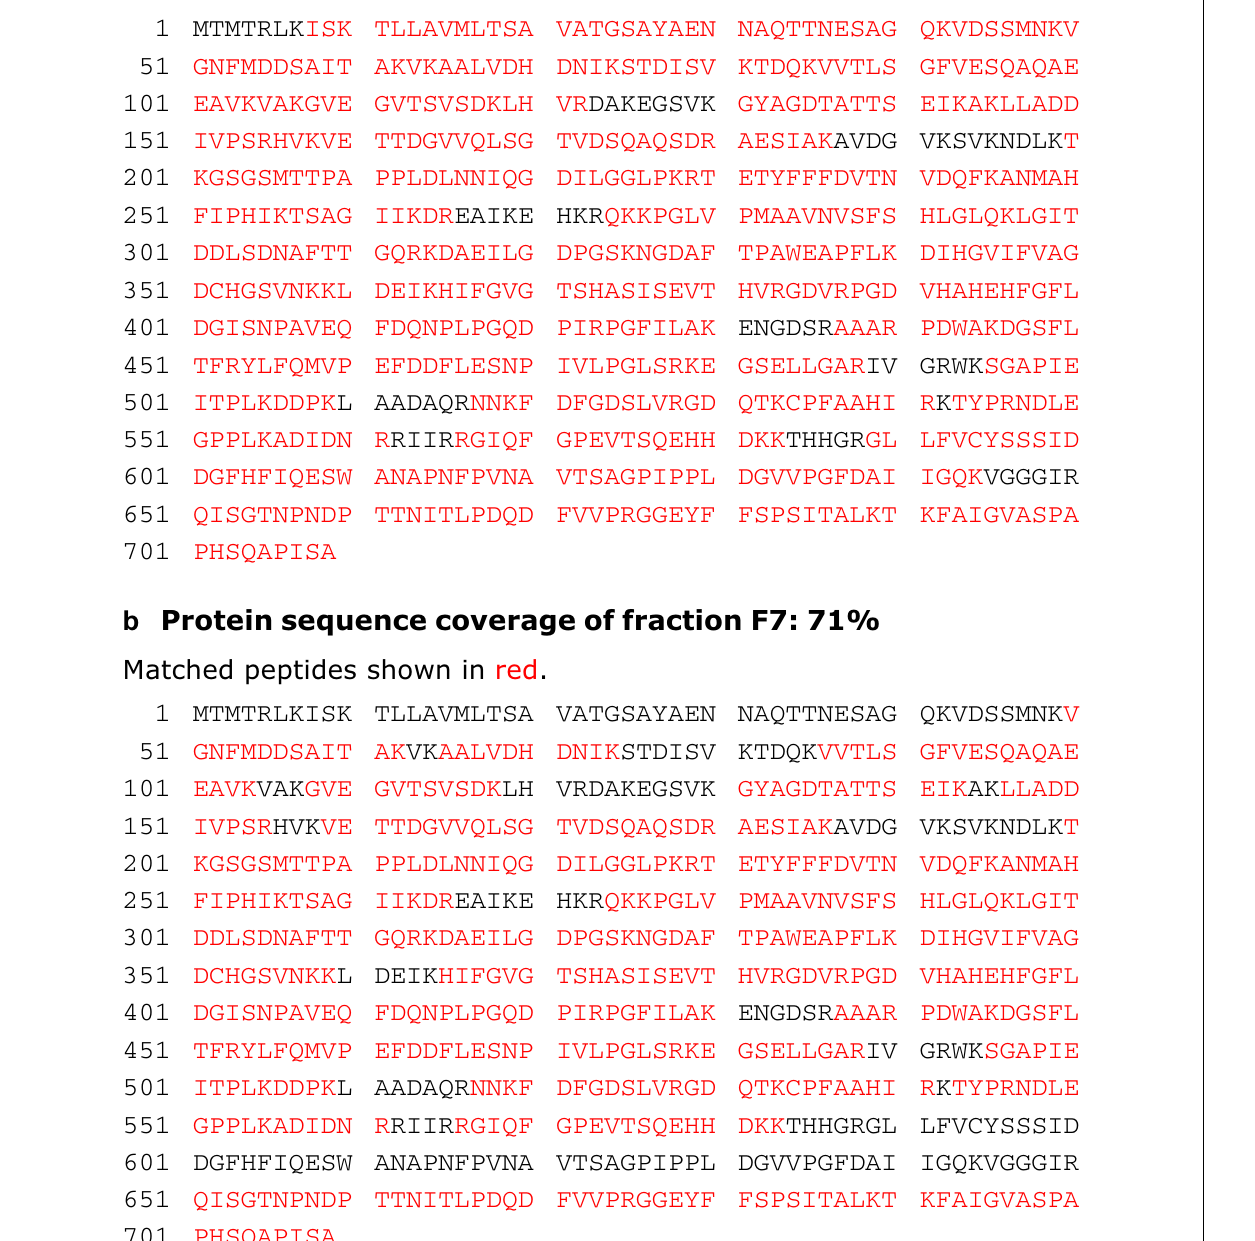
a Protein sequence coverage of fraction F2: 89% Matched peptides shown in red.